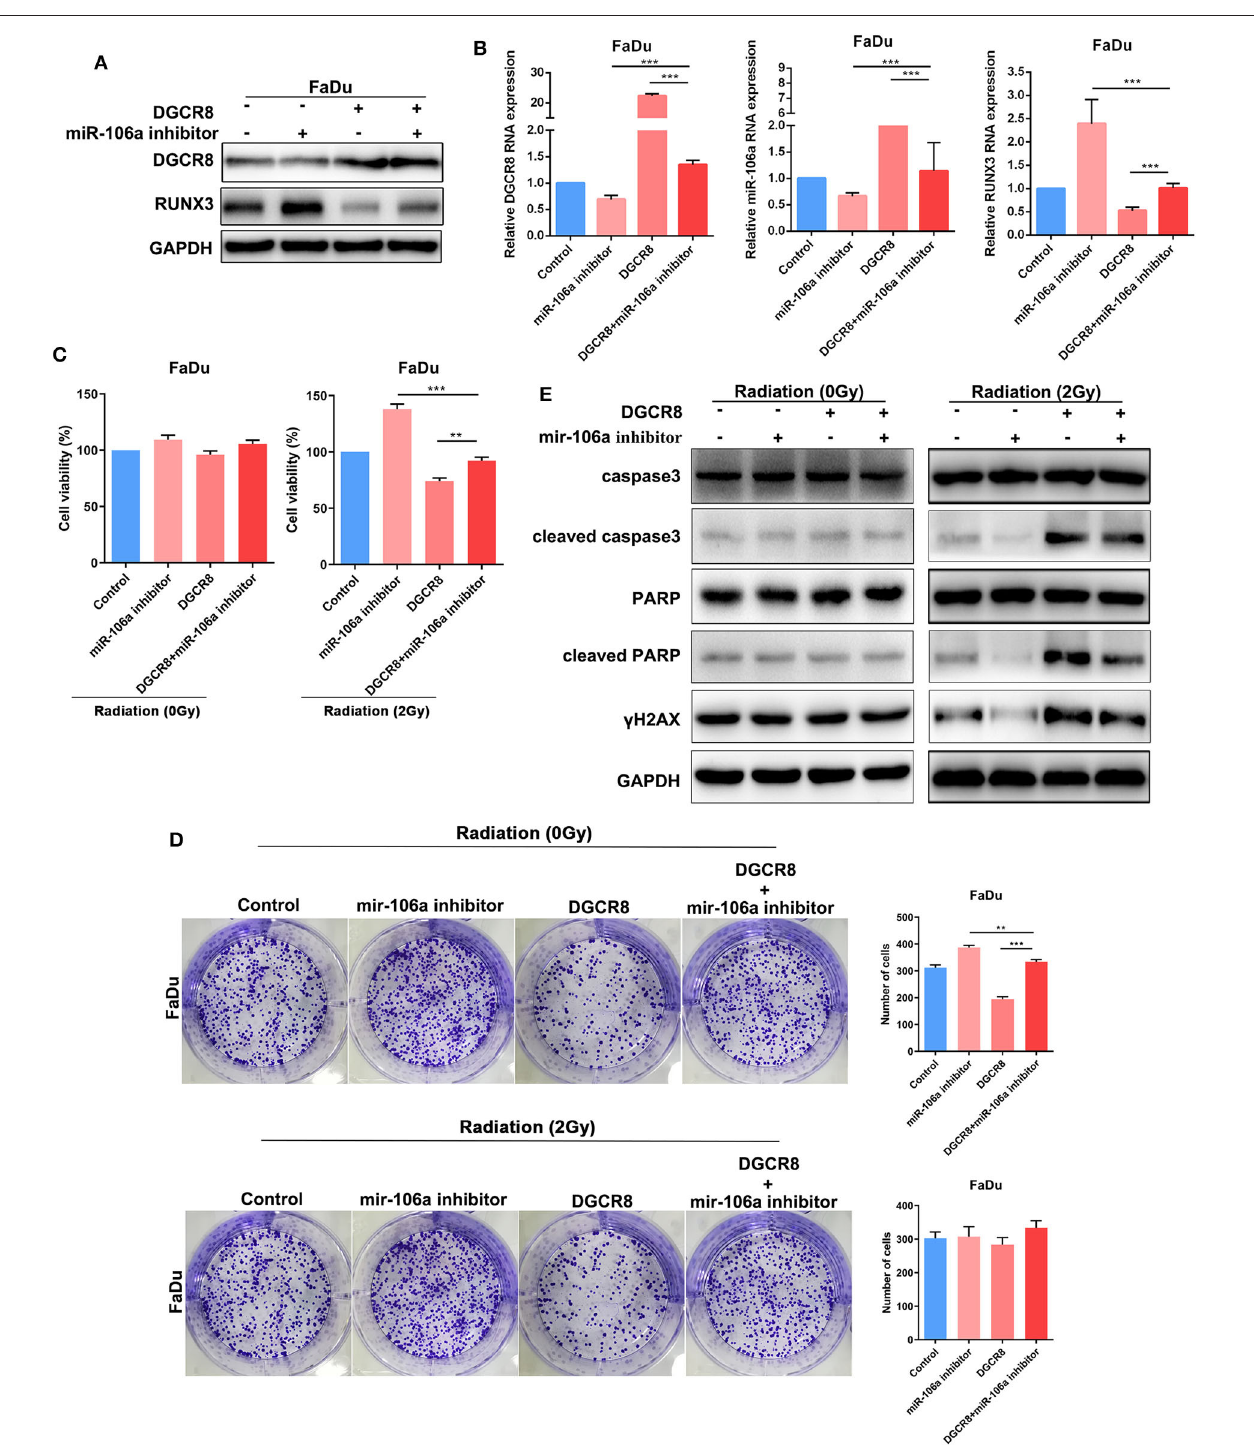
FIGURE 5 | Human papillomavirus (HPV) E7 inhibits the expression of RUNX3 and affects radiation sensitivity by promoting the expression of hsa-miR-106a. (A) Western blot showing rescue of RUNX3 expression level in FaDu. (B) Quantitative real-time PCR (RT-qPCR) was performed to detect DGCR8, miR-106a, and RUNX3 expression levels in FaDu. (C) Cell Counting Kit-8 (CCK-8) showing rescue of cell viability in FaDu in radiation or non-radiation condition. (D) The protein expressions of apoptosis-related caspase-3, PARP, and DNA damage-related γ H2AX were measured by Western blot. (E) The clone formation assay showing rescue of radiation sensitivity in FaDu. ** p < 0.01, *** p <